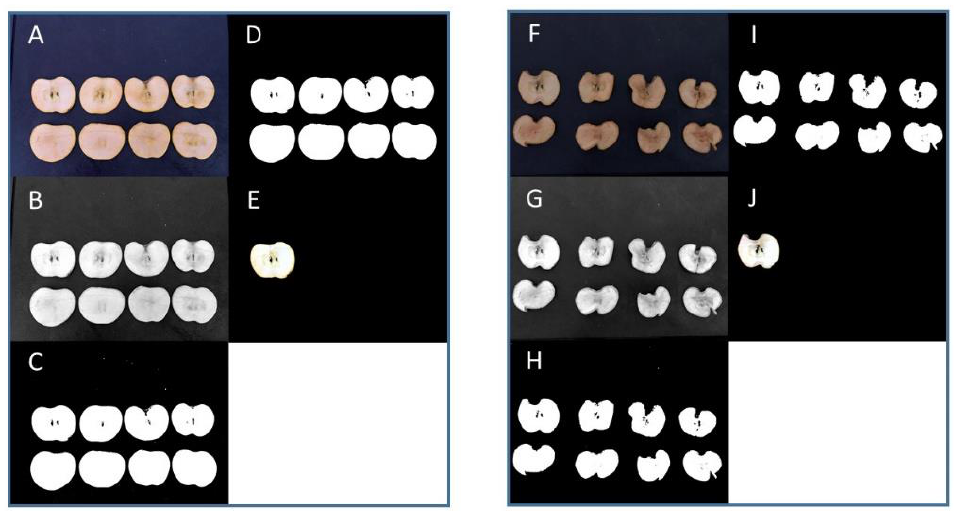
Figure 2. Image segmentation steps for detection of an apple slice at two time-instances: original image ( A , F ), contrast enhancement ( B , G ), thresholding ( C , H ), filtering of the largest labeled components ( D , I ), slice detection ( E , J ).